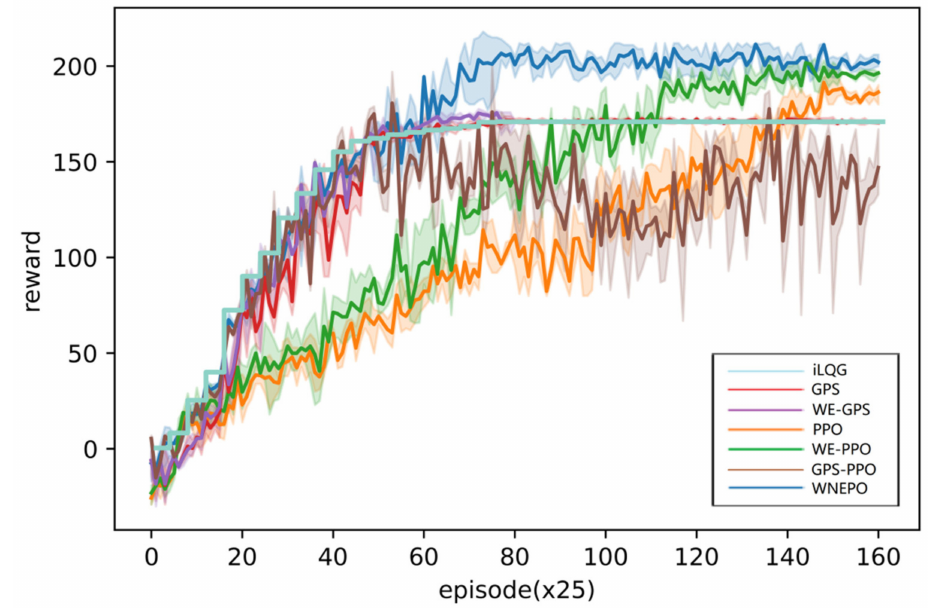
Figure 8. Comparison of our method and prior methods on bipedal robot walking